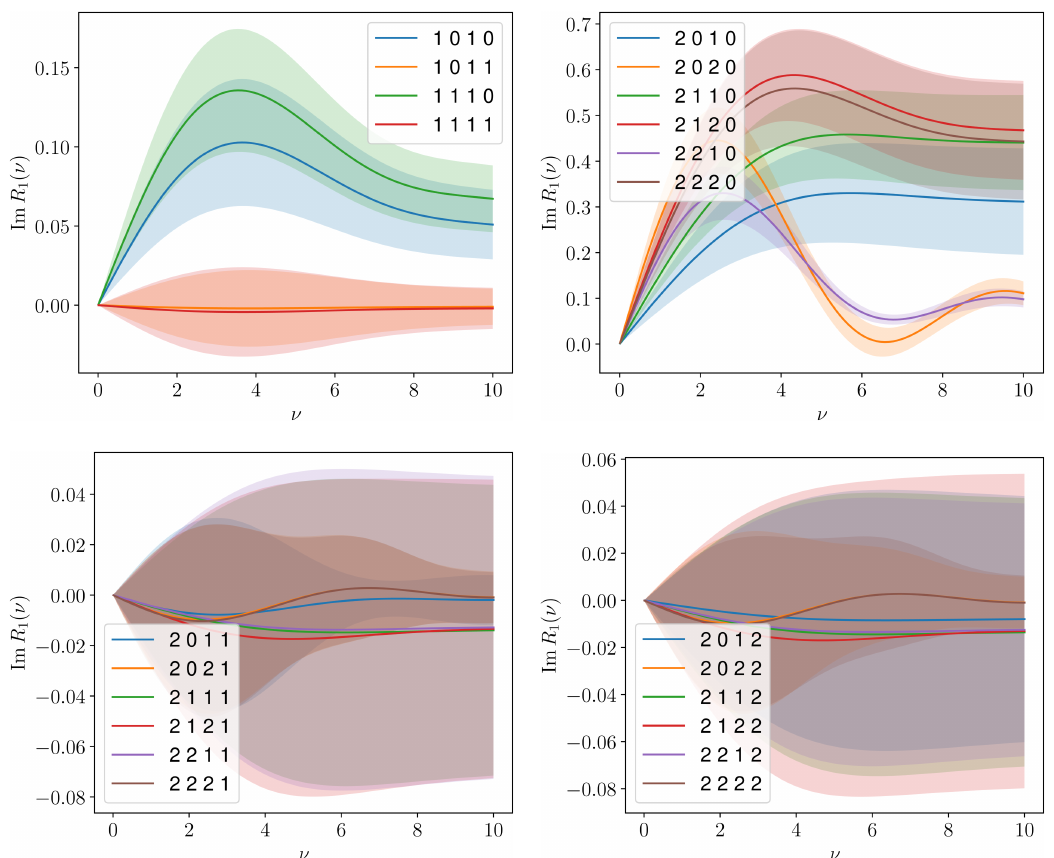
Figure 26 . The higher twist term, B 1 , results from fitting the imaginary component to the models. The numbers in the legend correspond to ( N ± , N